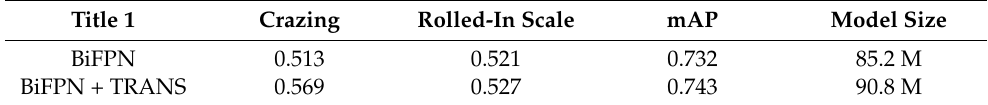
Table 1. The comparison between mAP and model size of different network.